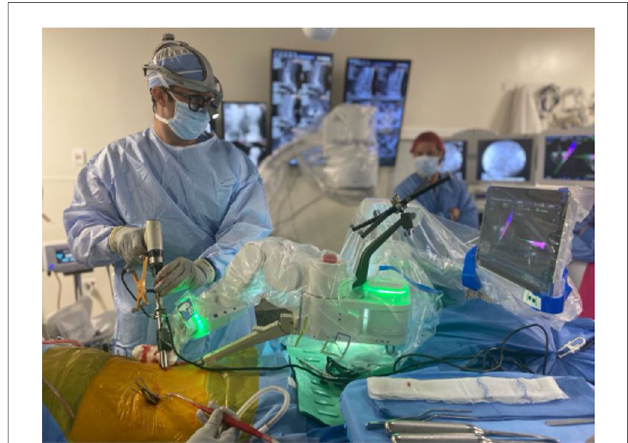
FIGURE 6 RAN surgeries incorporating registered navigated instrumentation, drill guides, and surgical monitors. Drill guide during surgical procedure combined with real-time visual feedback from the surgical navigation monitors. The navigation monitor shows real-time visual feedback based on the positioning of the navigated instrument. RAN, robotically assisted